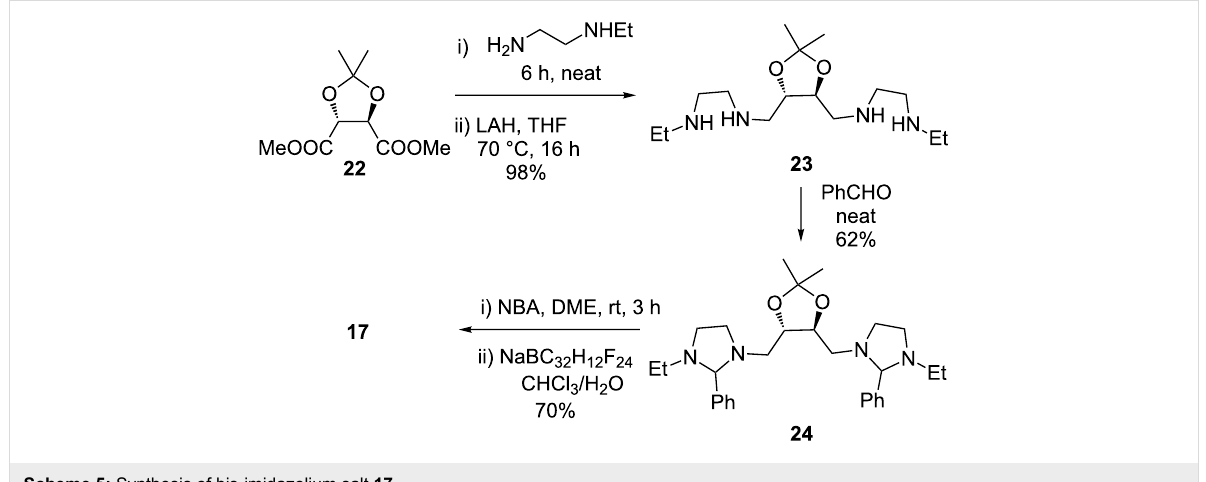
Scheme 5: Synthesis of bis-imidazolium salt 17 .